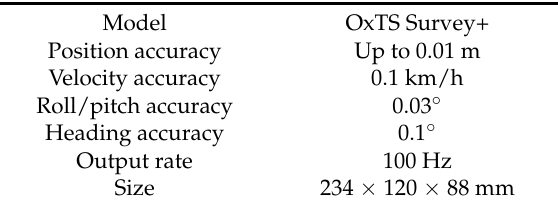
Table 3. Specifications of the GNSS/INS unit.